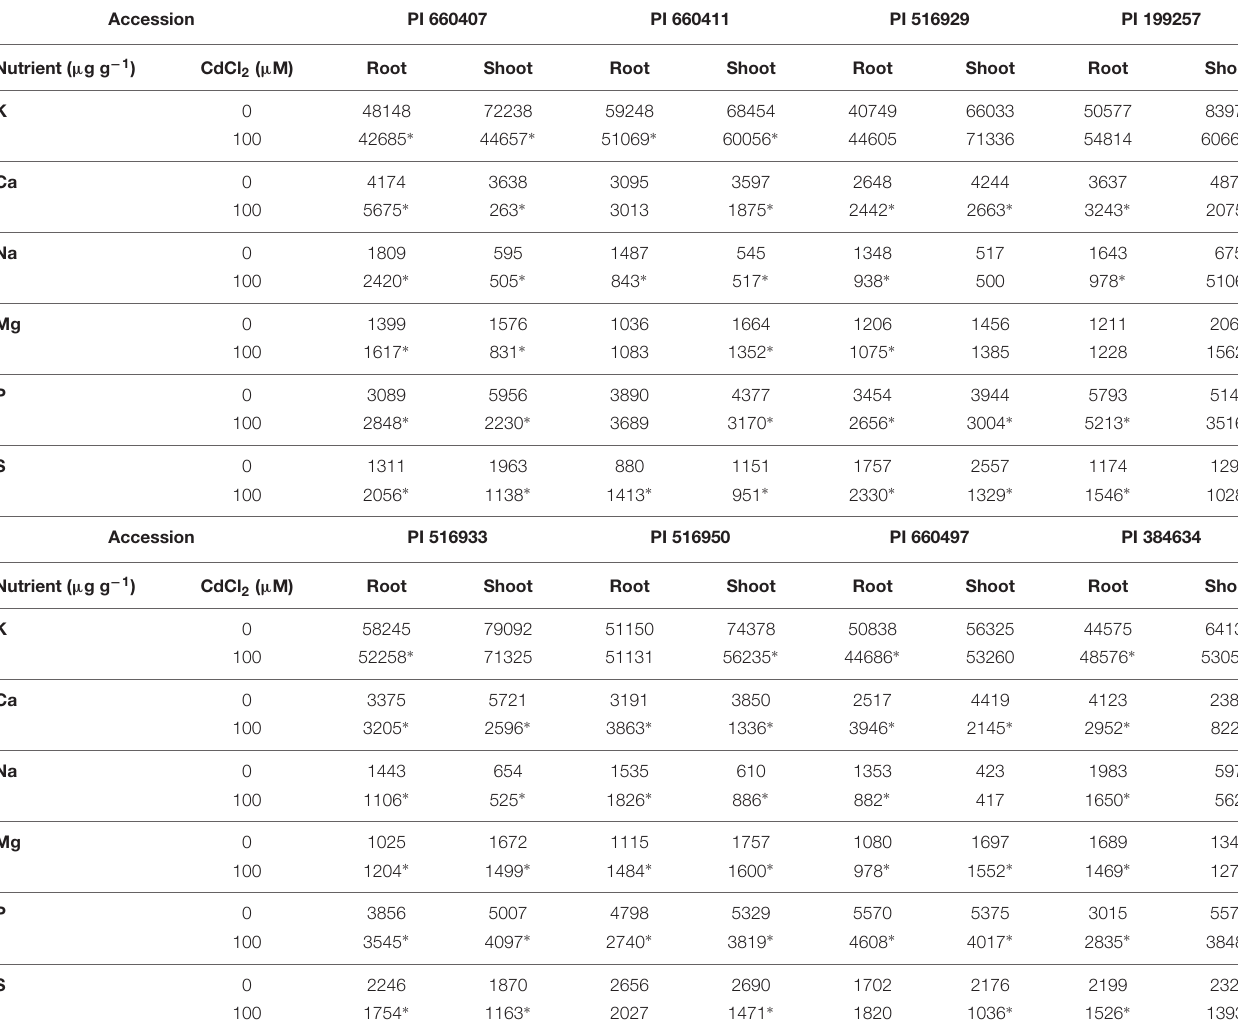
TABLE 2 | Macronutrients content in Cd-tolerant and Cd-sensitive accessions of M. truncatula grown in hydroponic pouches with 0 or 100 µ M CdCl 2 for 12 days. Accession PI 660407 PI 660411 PI 516929 PI